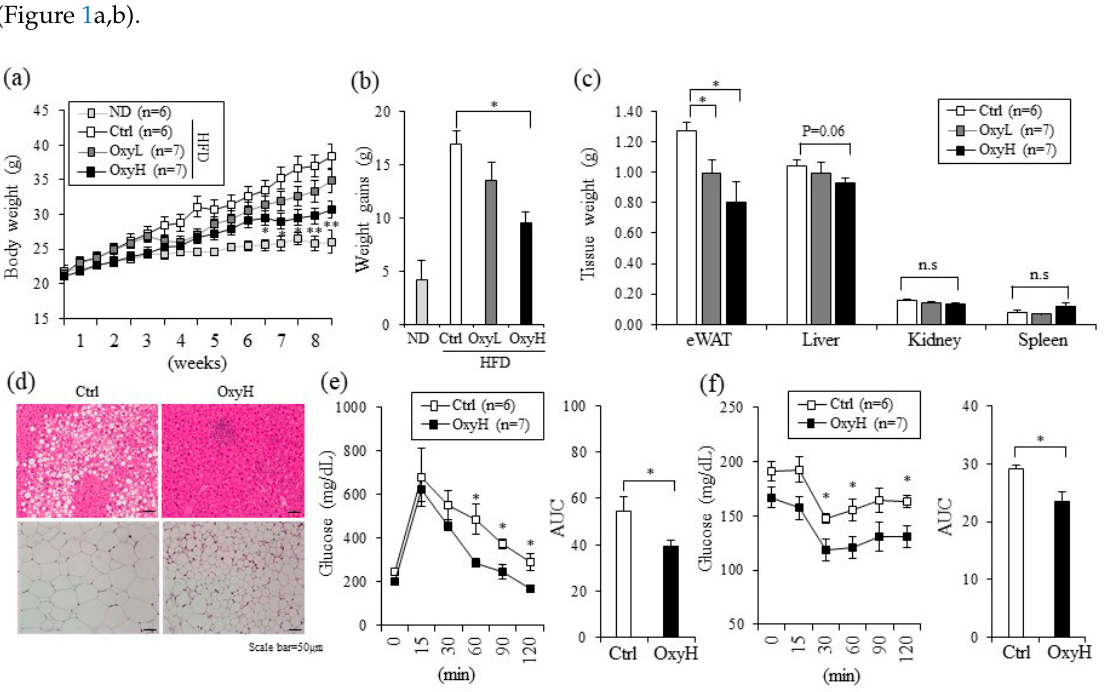
Figure 1. Oxyresveratrol prevents obesity and improves glucose metabolism in HFD-fed obese mice. ( a ) Body weight of vehicle control or oxyresveratrol-treated mice fed with high-fat diet (HFD) for 8 weeks. Male C57BL/6N mice were fed with a normal chow diet (ND, 20% fat) or HFD, 60% fat) and treated with vehicle control (Ctrl), oxyresveratrol (7.5 mg/kg, OxyL) or OxyH (15 mg/kg per day) for 8 weeks. ( b ) Body-weight gain of ND, HFD vehicle control (Ctrl) or oxyresveratrol-treated HFD-fed obese mice. ( c ) Epididymal fat (eWAT), liver, kidney, and spleen weights in HFD vehicle control (Ctrl) or oxyresveratrol-treated mice. ( d ) Representative hematoxylin and eosin (H&E) staining for sections of liver (top) and inguinal fat (iWAT) (bottom) from Ctrl and OxyH mice. Scale bar, 50 µ m. ( e ) Glucose tolerance test (left) and area under curve (right) in Ctrl or OxyH mice. Mice were fasted for 16 h before intraperitoneal injection of glucose (2 g/kg). ( f ) Insulin tolerance test (left) and area under curve (right) in Ctrl or OxyH mice. Mice were fasted for 16 h before intraperitoneal injection insulin (0.35 U/kg). Glucose levels were measured from tail blood samples collected at the indicated time points. Data represent means ± s.e.m. Statistically significant differences between vehicle control (Ctrl) and Oxy-treated mice were determined using Student’s t -test (* p < 0.05; ** p <